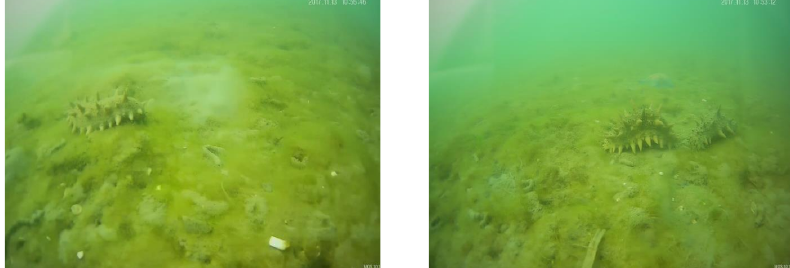
Figure 3. Underwater robots taking photographs of sea